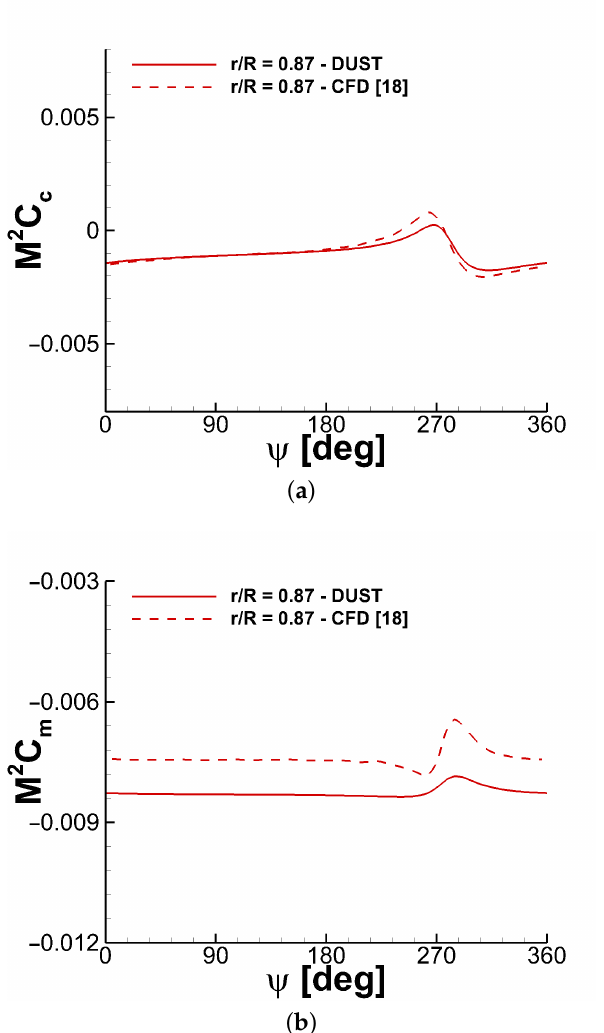
Figure 10. Comparison of the time histories of the non-dimensional chord force M 2 c c and pitching moment M 2 c m on the proprotor blade at r / R = 0.87, α = 5 ◦ , V ∞ = 220 kts, Ω = 517 RPM